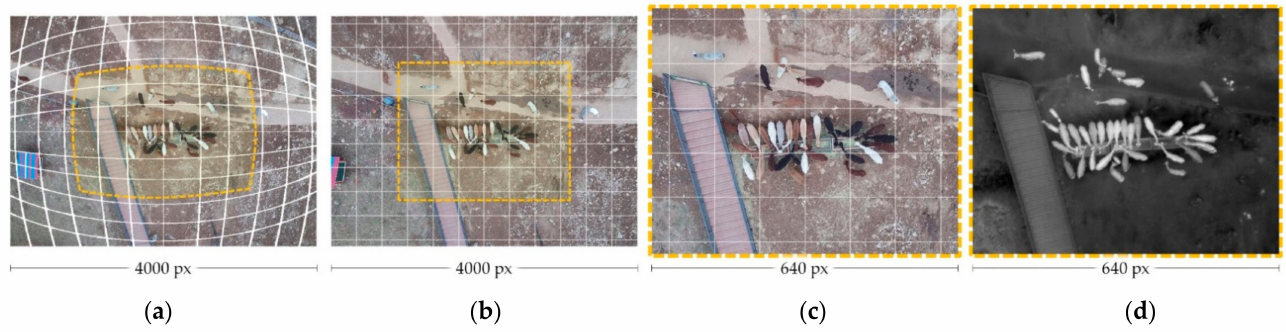
Figure 4. Example of focal length distortion and correction. ( a ) Original RGB image (distorted), ( b ) corrected RGB image, ( c ) clipped RGB image, and ( d ) original thermal image.